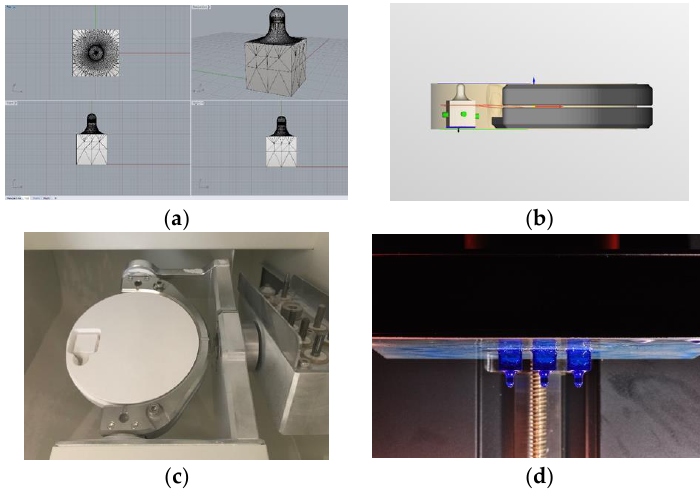
Figure 2. The zirconia abraders were fabricated by milling, and the metal abrader was 3D printed, invested, and cast into a CoCr alloy. ( a ) computer assisted design for the abraders; ( b ) calculation and arrangement on CAM software (hyperDENT ® version 7.4, FOLLOW-ME! Technology GmbH, Munich, Germany) for the zirconia abrader; ( c ) the zirconia abrader inside a block after milling; ( d ) sacrifice patterns made of castable 3D printing resin for the metal abraders.